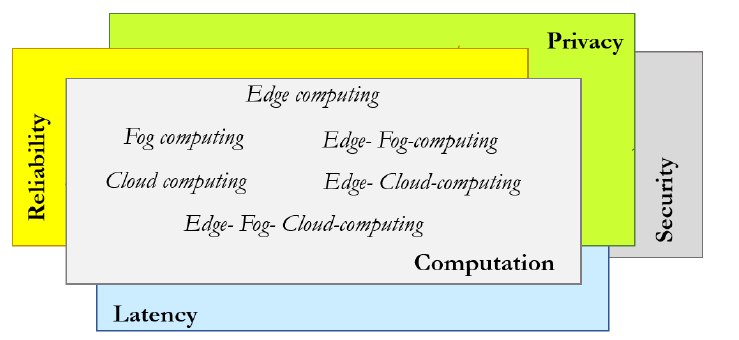
Figure 12. Overlapping of the computation functional block and four qualities of IoT